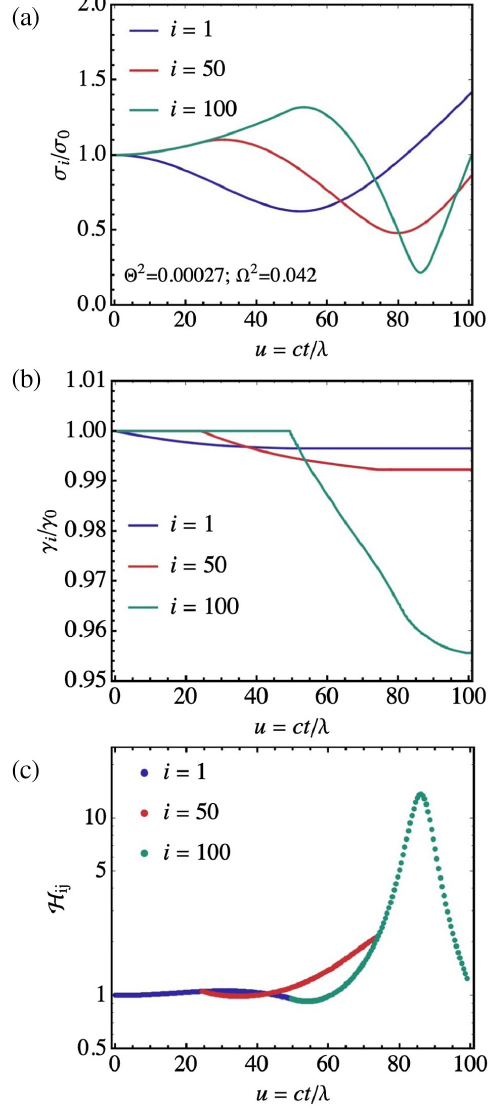
¼ i along each ij